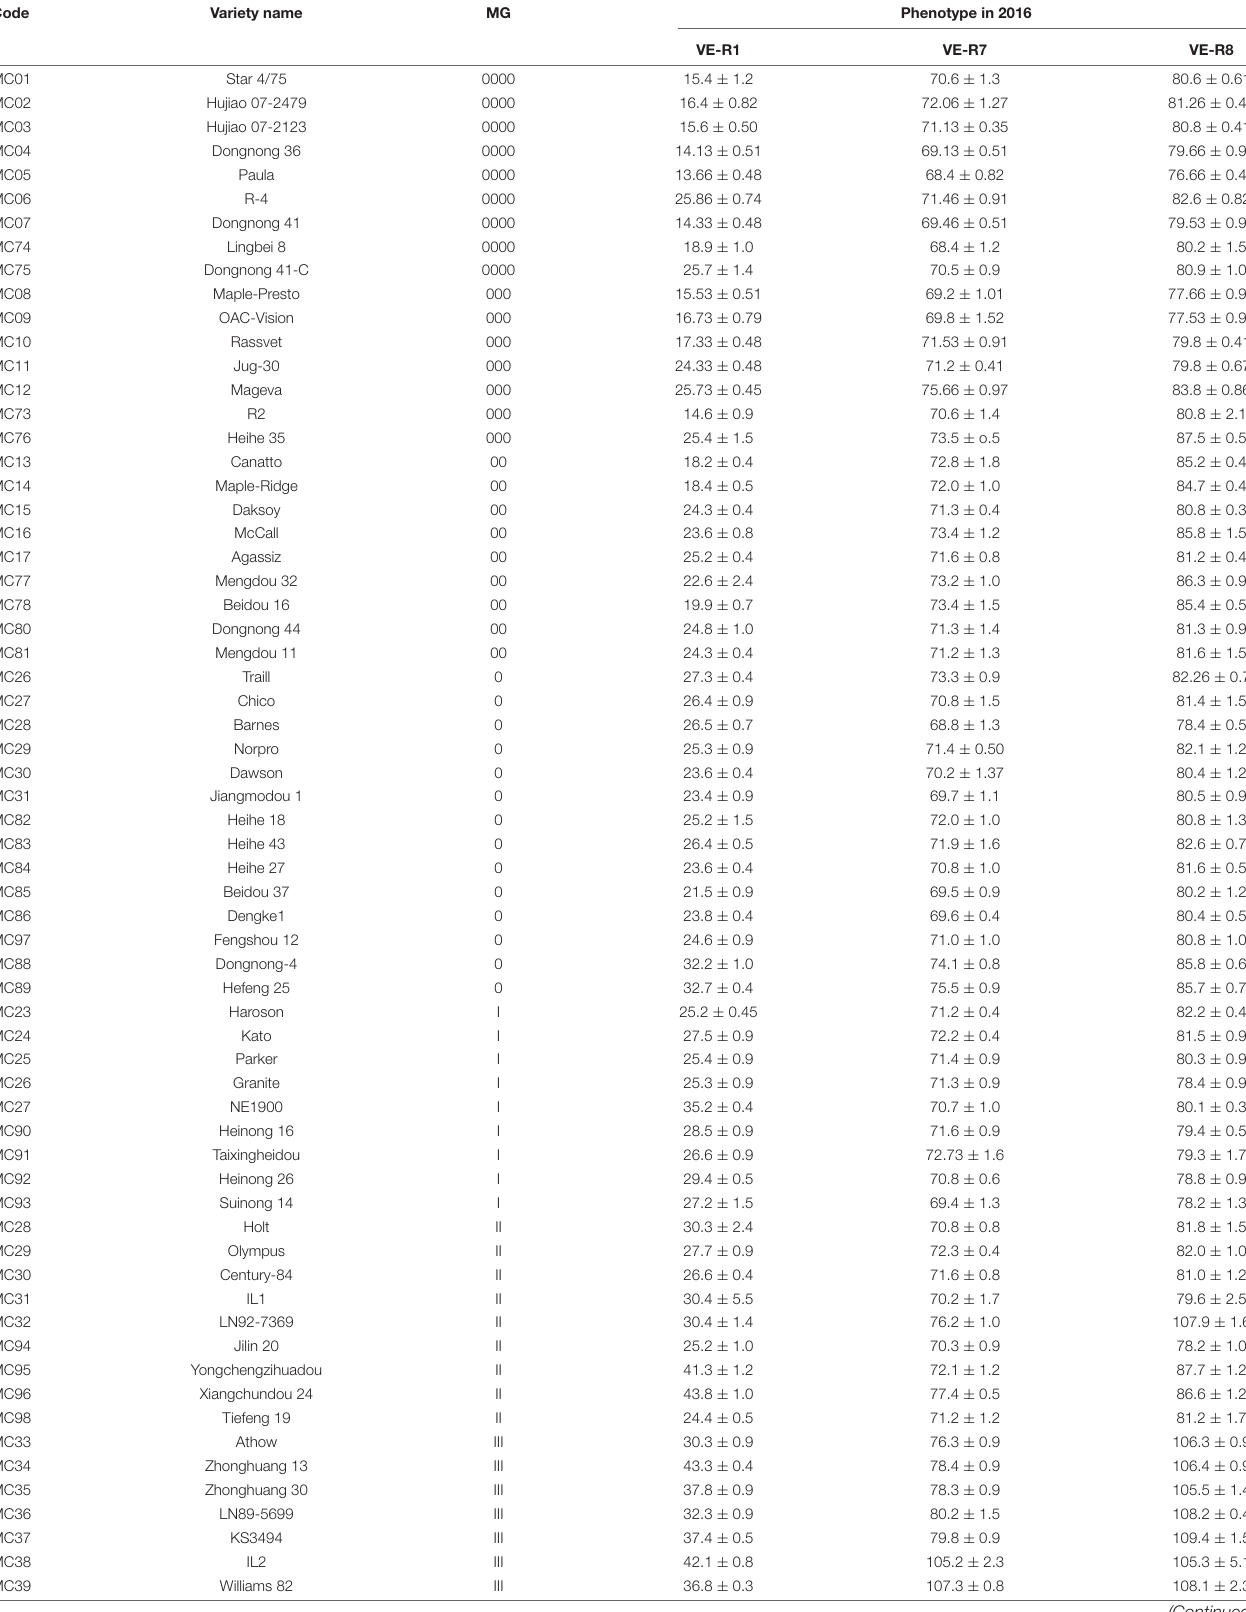
TABLE 2 | Phenotypic variation of soybean varieties at